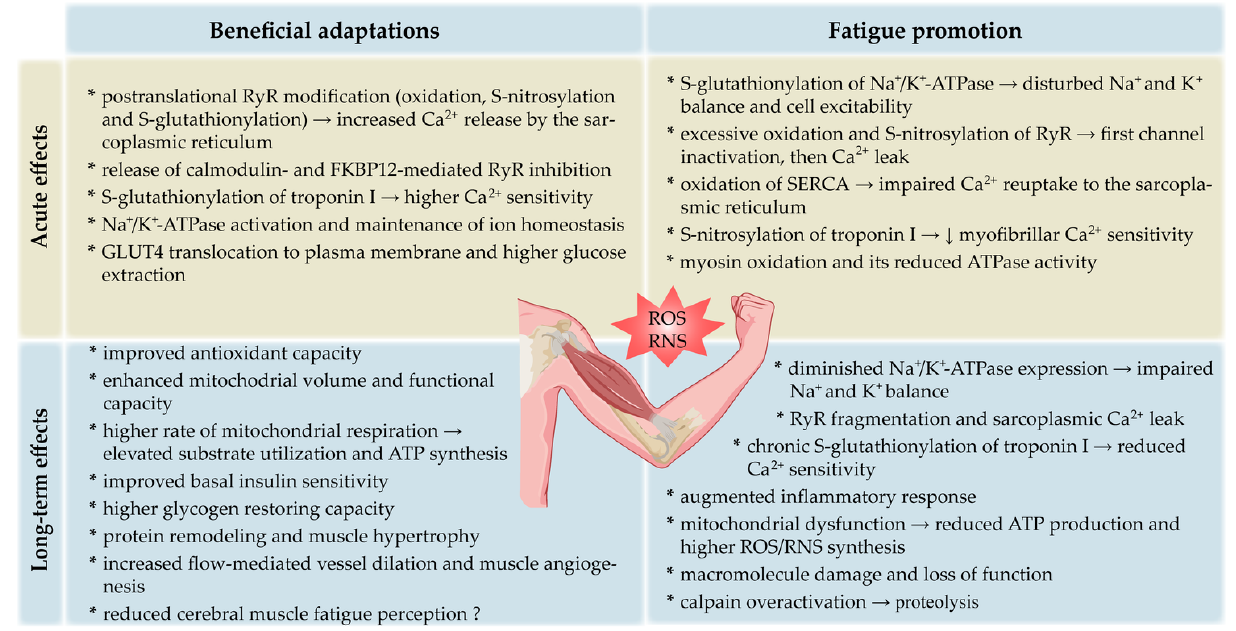
Figure 4. A summary of immediate and long- term ROS/RNS -mediated effects on contractile prop-